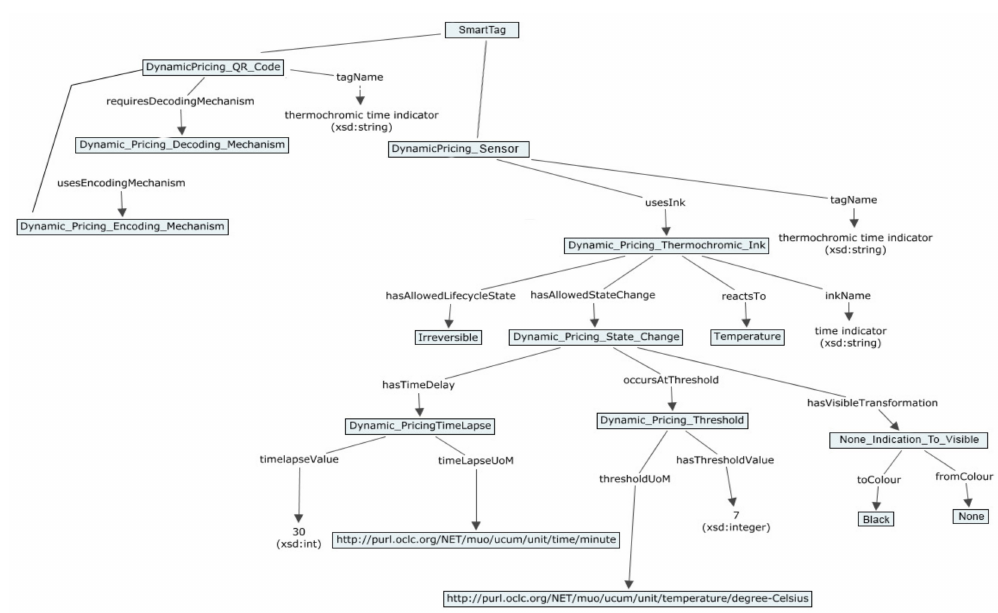
Figure 24. Semantic model for use case with